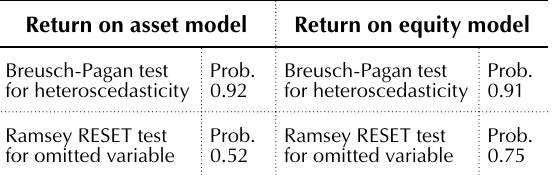
Table 4. Robustness test